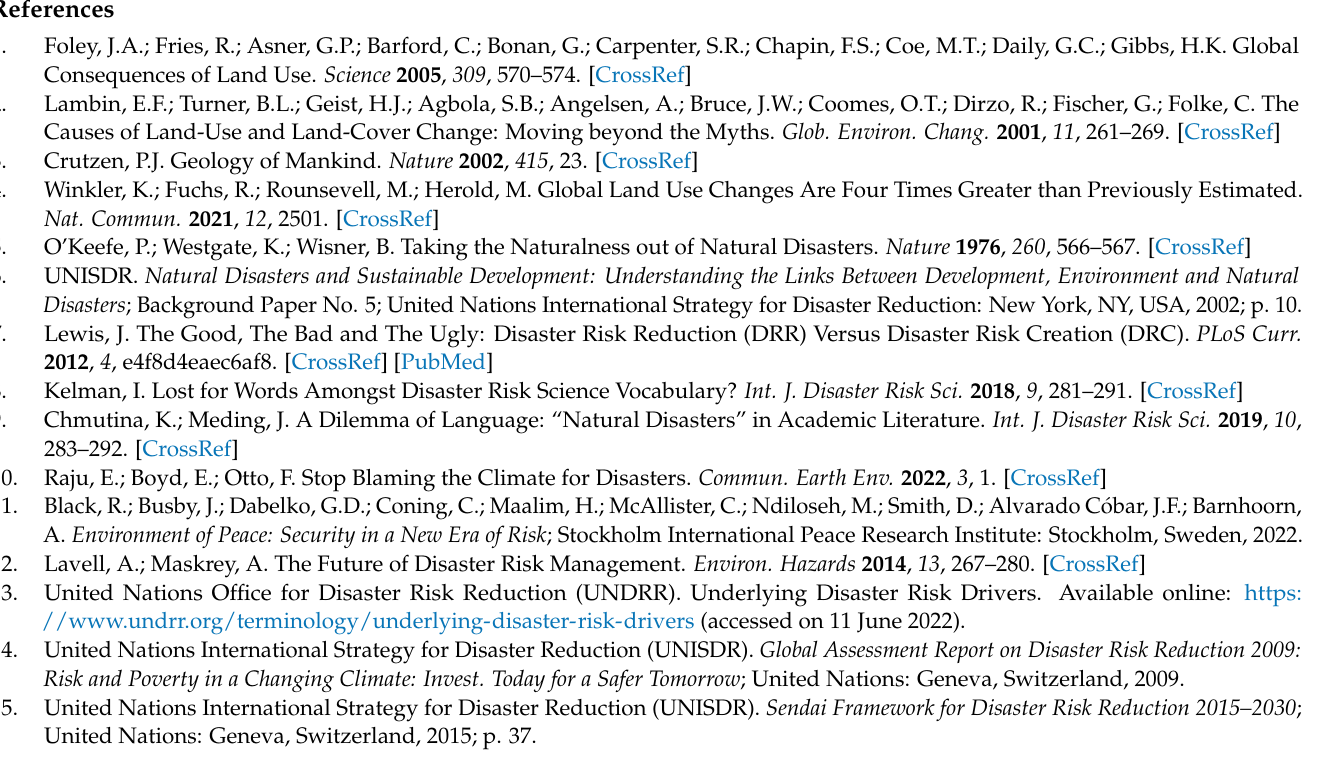
Table S2: Confusion Matrix for the year 1990; Table S3: Confusion Matrix for the year 1995; Table S4: Confusion Matrix for the year 2001; Table S5: Confusion Matrix for the year 2005; Table S6: Confusion Matrix for the year 2010; Table S7: Confusion Matrix for the year 2015; Table S8: Confusion Matrix for the year